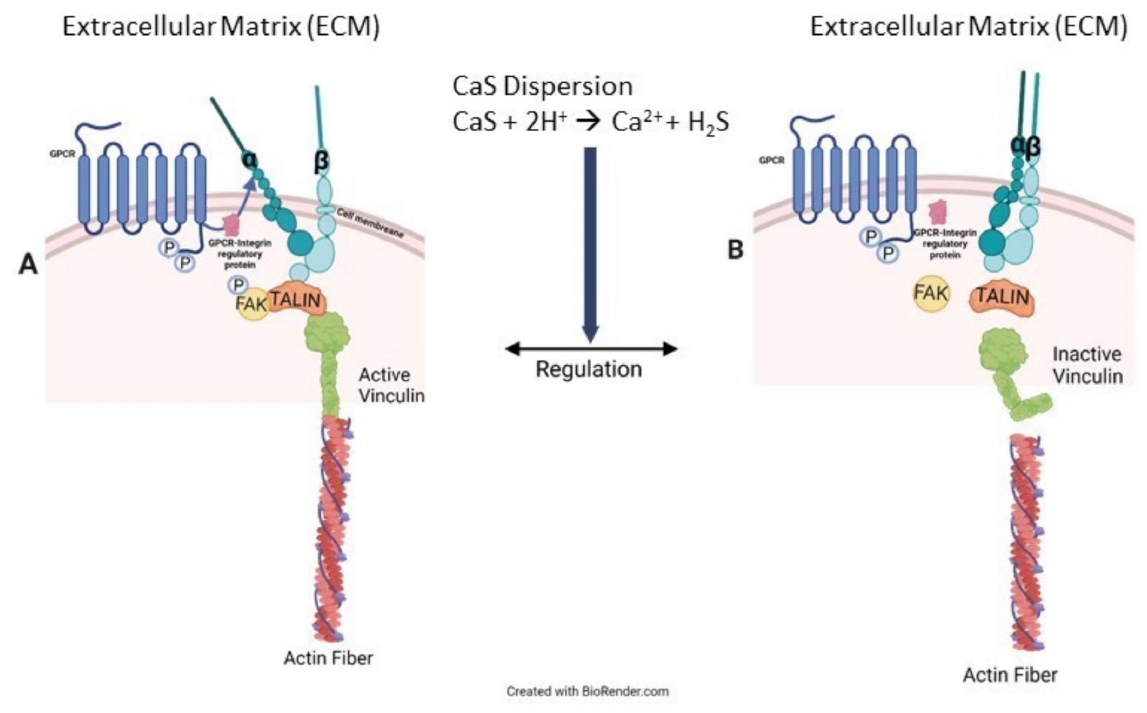
Figure 7. Cancer cells usually overexpress FAK, as illustrated in ( A ) on the left-hand side of the figure. This overexpression results in the formation of active integrin–FAK–talin–vinculin–actin focal adhesion points (FAP). CaS dispersion increases inactive vinculin in the cytoplasmic fluid, as in ( B ), which is attributed to the appropriate regulation of FAK and, consequently, the FAP formation mechanism. Proper FAK function also facilitates the activation of cell death